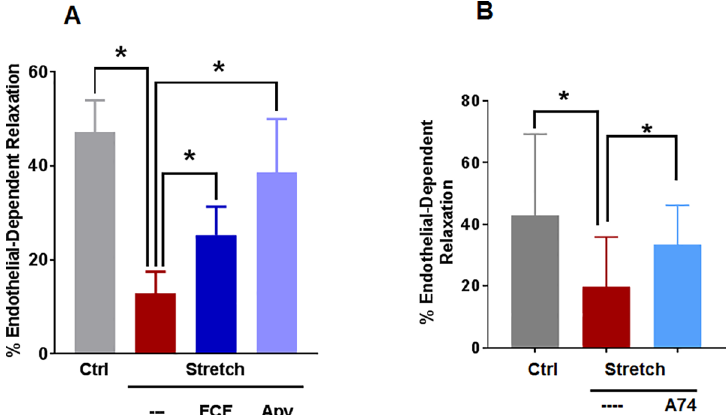
Fig 1. Decreasedendothelial function in a subfailure overstretch RA model was restored with apyrase and P2X7R antagonists FCF and A740003.A. RA was nonstretched (Ctrl), longitudinally stretched to twice its ex vivo length (Stretch), longitudinally stretched before treatment with FCF (100 μ M, Stretch+FCF) or stretched before treatment with apyrase(4units/mL, Stretch+Apy). Vessels were pre-contractedwith phenylephrine(0.5 μ M) and relaxed with carbachol (0.5 μ M), n = 7–15, * p < 0.05 comparedto control, (paired t-test). B , RA was unstretched(Ctrl) or stretched and incubatedwith A740003 [19, 26] (100 μ M,